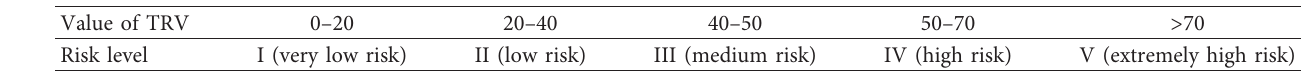
Table 12: Risk value assessment of water inrush disaster.